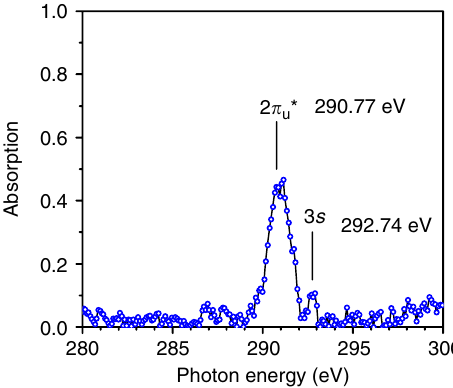
Fig. 4 Carbon dioxide K-shell photoabsorption spectrum. The